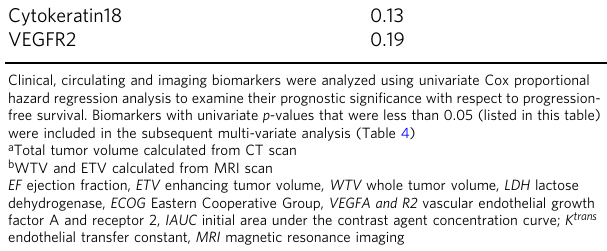
Clinical, circulating and imaging biomarkers were analyzed using univariate Cox proportional hazard regression analysis to examine their prognostic signi fi cance with respect to progression- free survival. Biomarkers with univariate p -values that were less than 0.05 (listed in this table) were included in the subsequent multi-variate analysis (Table 4) a Total tumor volume calculated from CT scan b WTV and ETV calculated from MRI scan EF ejection fraction, ETV enhancing tumor volume, WTV whole tumor volume, LDH lactose dehydrogenase, ECOG Eastern Cooperative Group, VEGFA and R2 vascular endothelial growth factor A and receptor 2, IAUC initial area under the contrast agent concentration curve; K trans endothelial transfer constant, MRI magnetic resonance